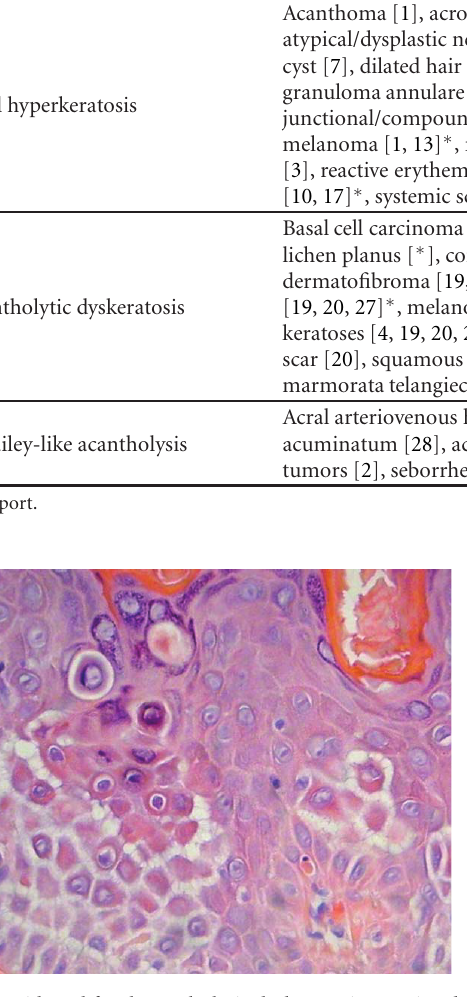
Figure 3: Incidental focal acantholytic dyskeratosis associated with prominent solar elastosis. This occurred in association with an excision of a melanoma in situ. (400X magnification, hematoxylin, and eosin stain). Figure 4: Incidental focus of Hailey-Hailey-like acantholysis,